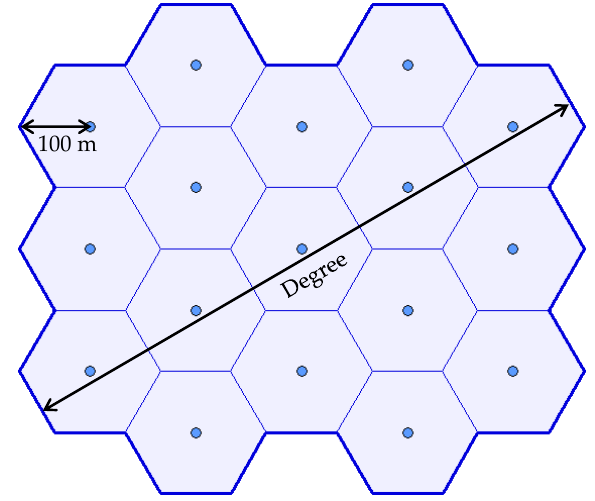
Figure 10. Area of interest created by joining hexagons.